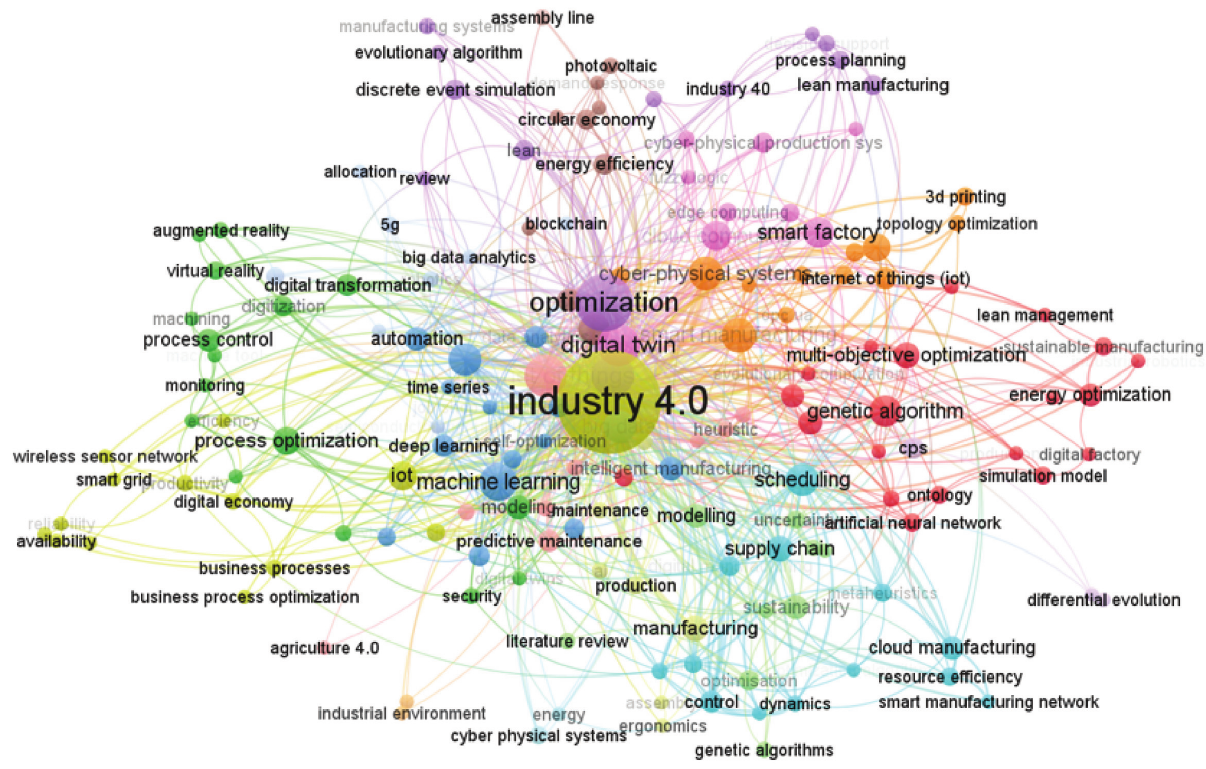
Figure 7: The linkage of